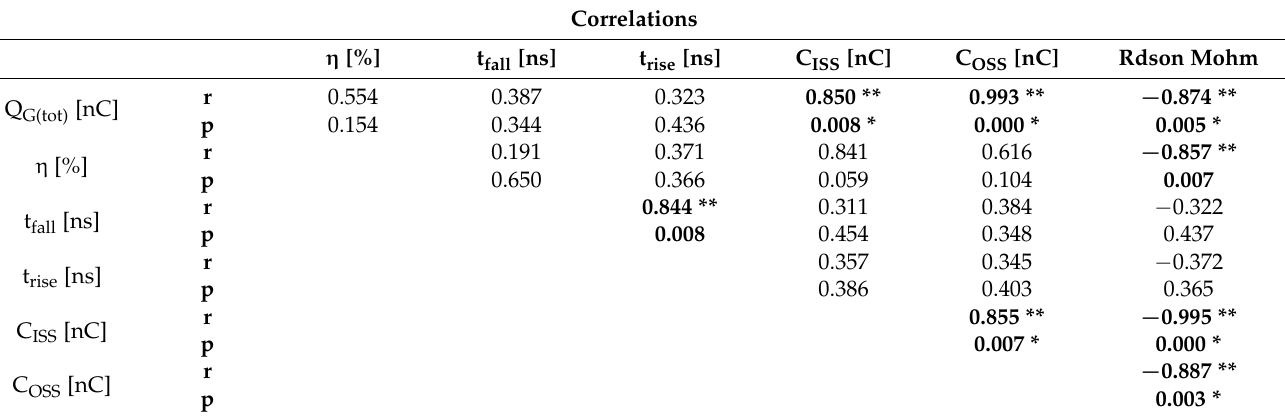
Table 4. Correlation analysis of characterization